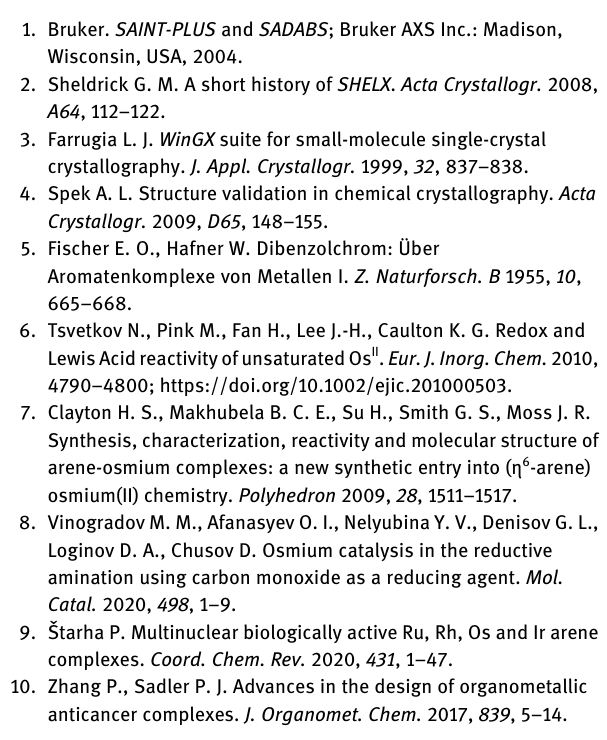
the Os center is calculated to be 1.664 Å. The benzene ligand is symmetrically coordinated to the metal with the six Os – C bond lengths in the narrow range of 2.165 – 2.171 Å with no